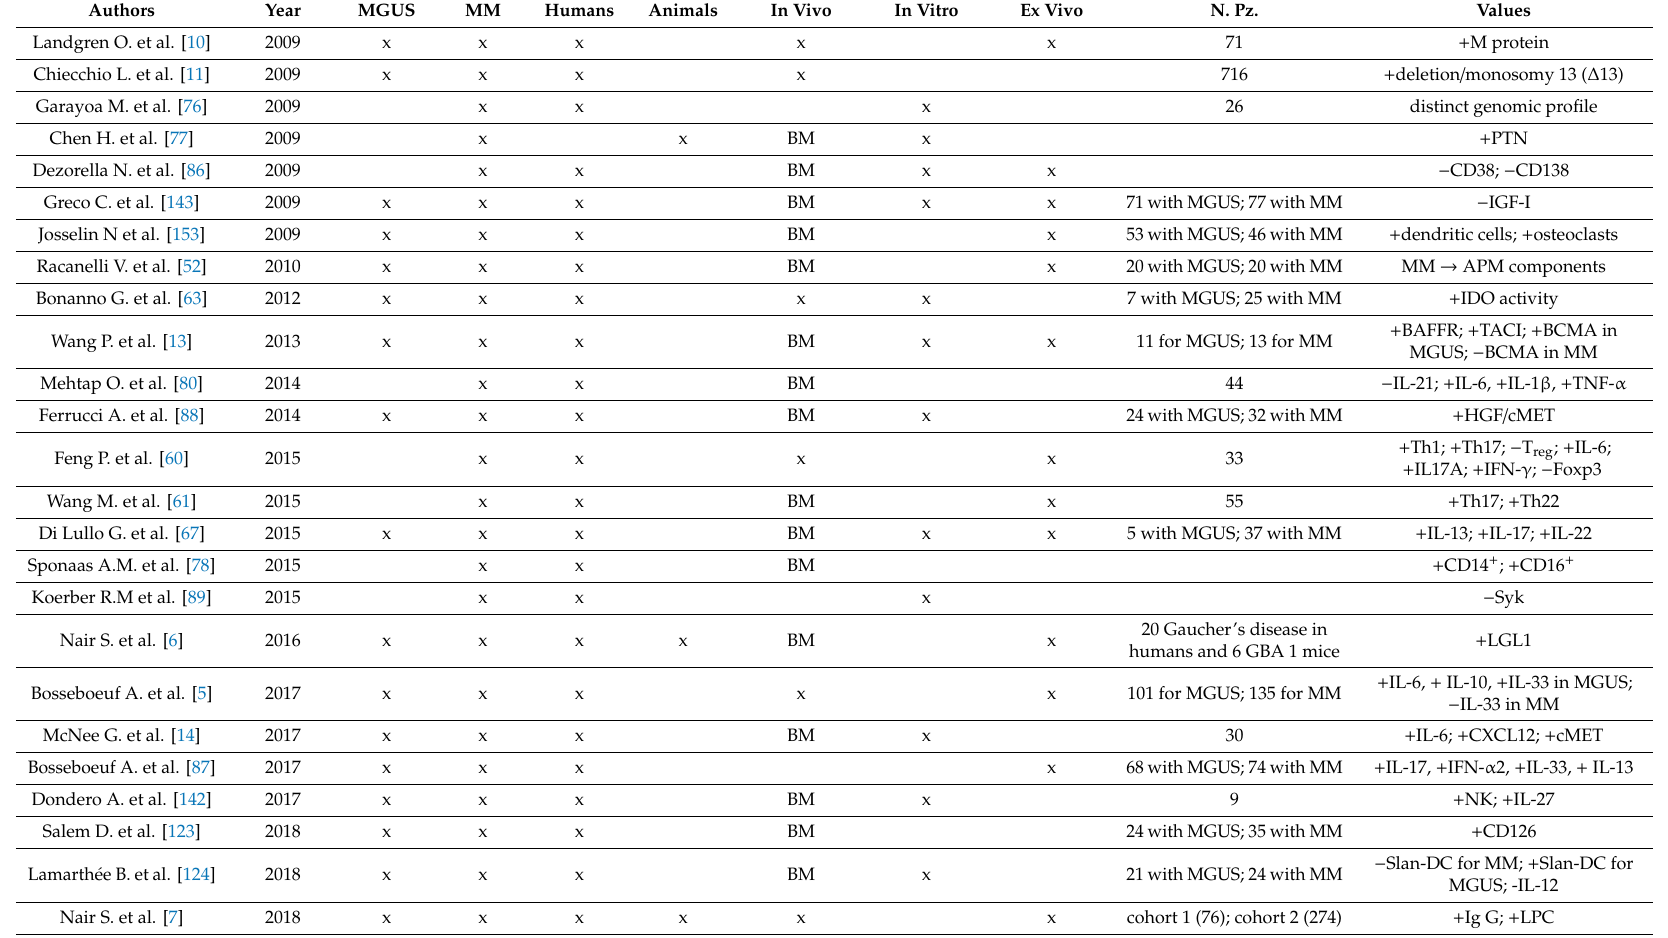
Table 1. List of the most recent studies (2009–2019) concerning the monoclonal gammopathy of undetermined significance (MGUS) and multiple myeloma (MM) cytokine profiles. Values + = molecules increased. Values − = molecules decreased. BM = bone